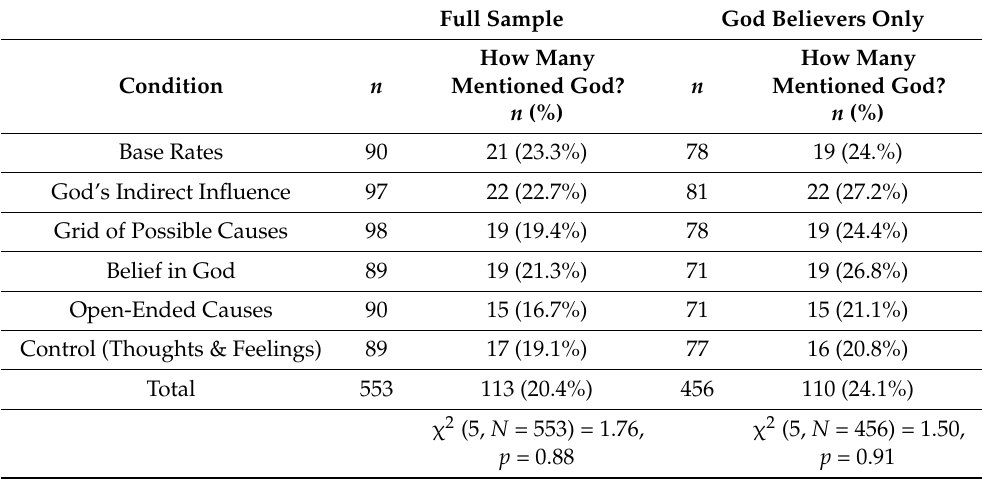
Table 2. Effects of Experimental Condition on Spontaneous Mentions of GTG (Open-Ended Item).